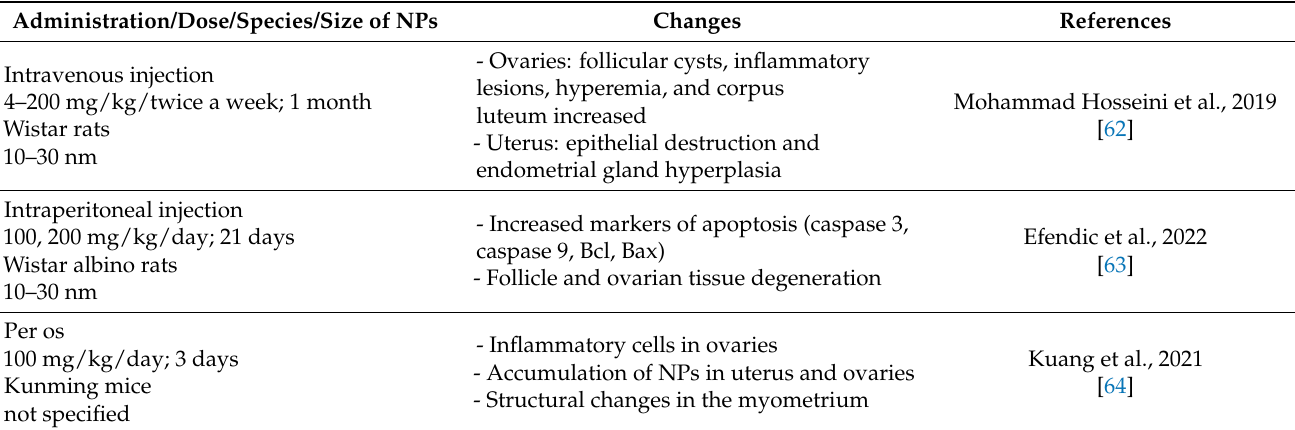
Table 4. Alterations in the female reproductive system caused by ZnO